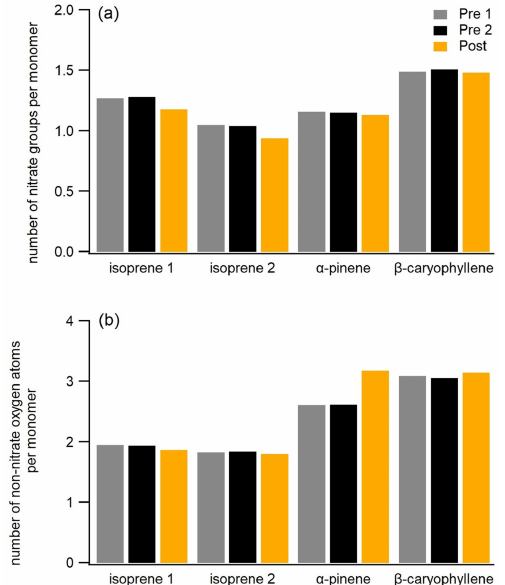
Figure 5. Mass-weighted number of nitrate groups per monomer (number of carbon atoms/number of the carbon atoms in precursors – 5, 10, and 15 for the isoprene, α -pinene, and β -caryophyllene SOA, respectively) and mass-weighted number of non-nitrate oxy- gen atoms per monomer for three filters (Pre 1, Pre 2, and Post) for all